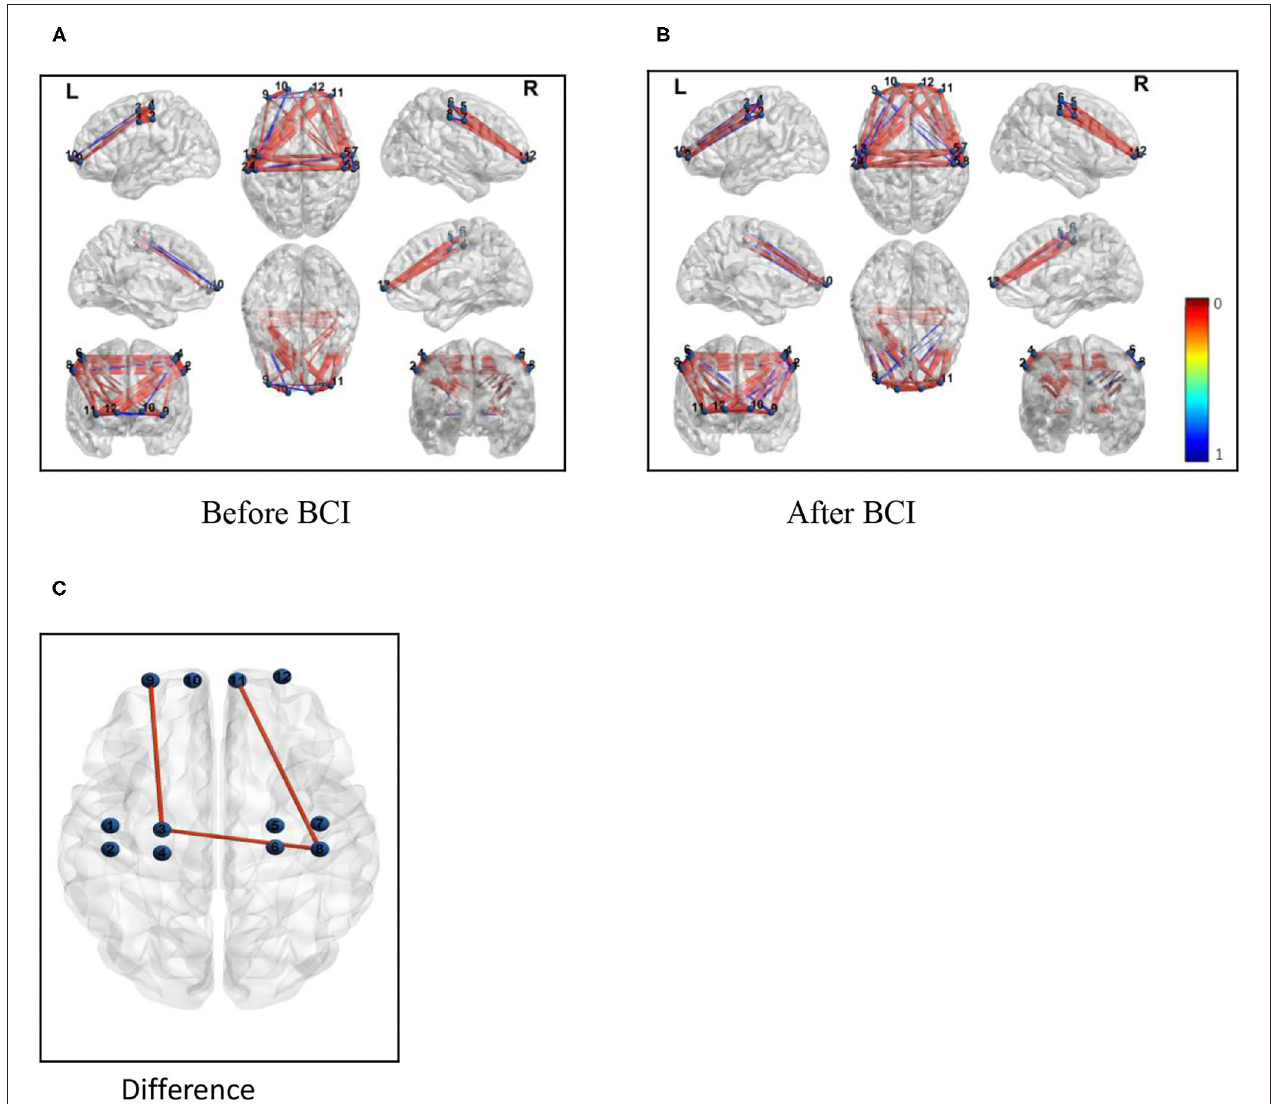
FIGURE 6 | Functional connectivity (correlation) change measured after BCI training. Channels with differences in FC at baseline and the 1-month follow-up (Pearson correlation). (A) Correlations between each channel before BCI training. (B) Correlations between each channel after BCI training. (C) Correlations between the ipsilateral M 1 and the ipsilateral frontal lobe and the contralateral M 1 increased and the FC between the contralateral M 1 and the contralateral frontal lobe was also increased.